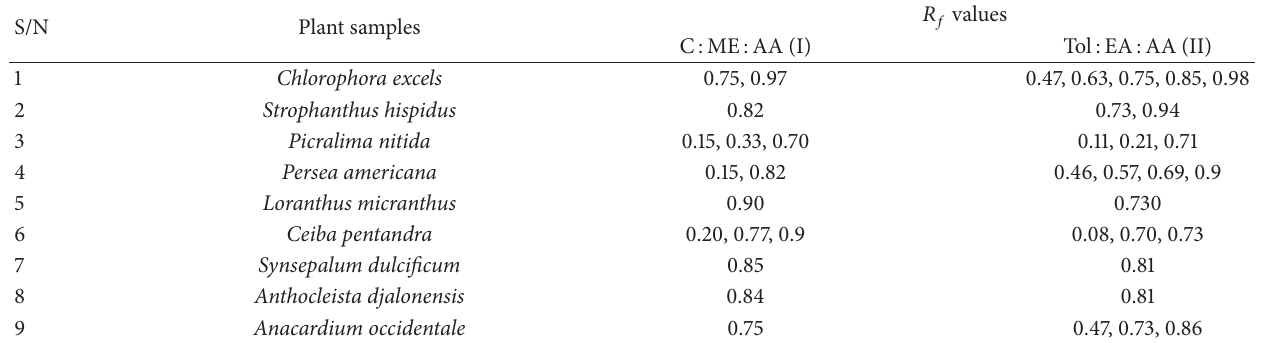
Table 2: Thin Layer chromatography retention factor using mobile phase C:ME: AA (I) and Tol: EA:AA (II) in the ratio of 5 :4 :1.